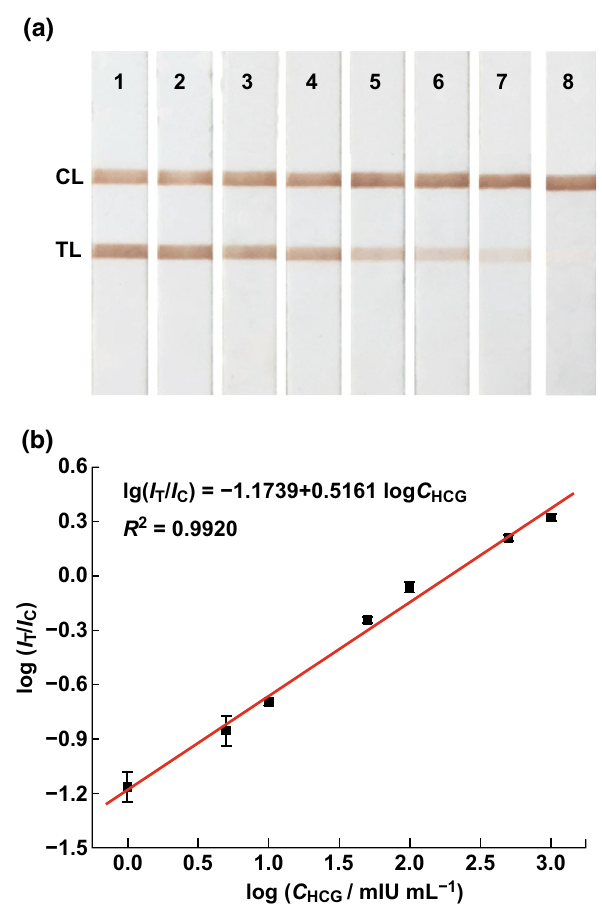
Fig. 8 a HCG strips used for standard curve. Concentrations from 1 to 8 were 1000, 500, 100, 50, 10, 5, 1, and 0 mIU mL −1 . b Standard curve for HCG strips